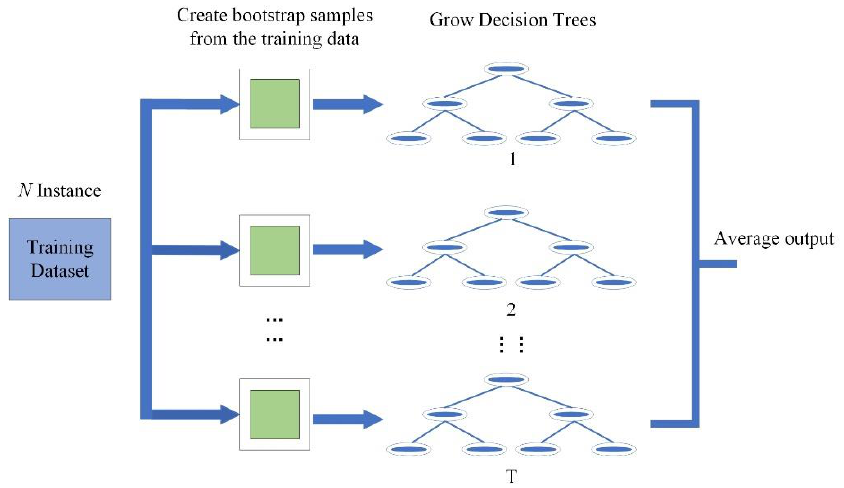
Figure 2. The schematic diagram of random forest regression (RFR).